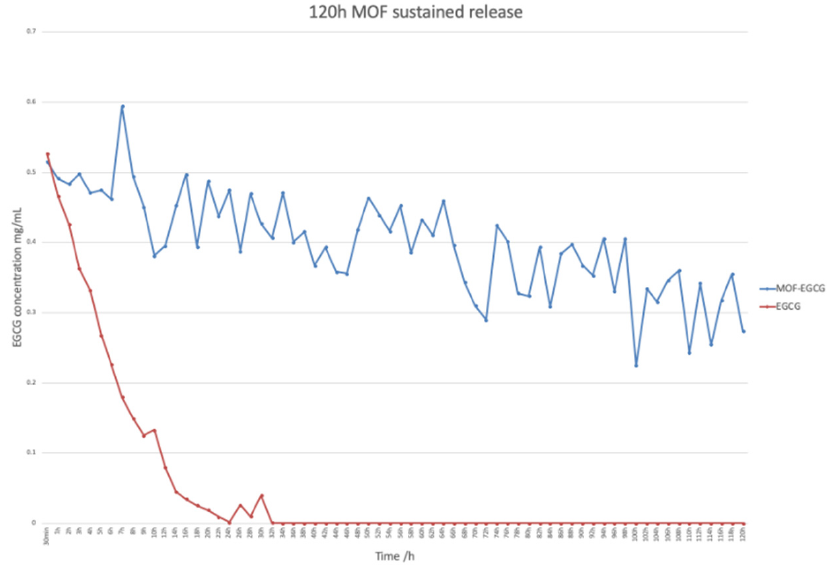
Figure 6. EGCG @ MOF Zn(BTC) 4 slows EGCG degradation.